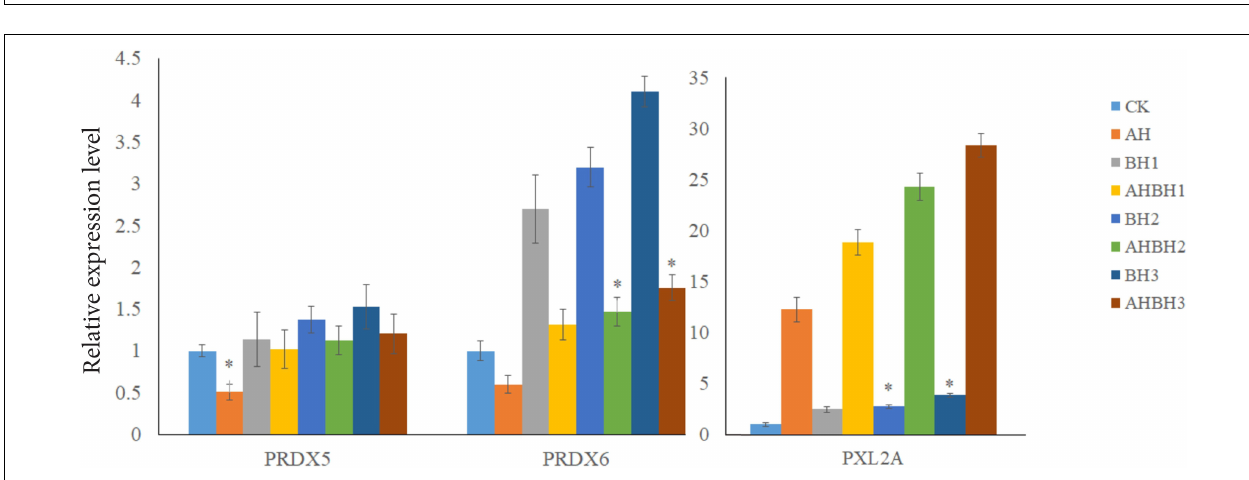
FIGURE 8 | Relative expression of Prx5, Prx6, and PXL2A genes in the hepatopancreas of C. japonica . Infected with A. hydrophila (AH), C. japonica immersed in berberine hydrochloride at 100 mg/L (BH1) and 200 mg/L (BH2), C. japonica immersed in berberine hydrochloride at 300 mg/L (BH3), C. japonica immersed in berberine hydrochloride at 100 mg/L, and injected with A. hydrophila 1 (BHAH1), C. japonica immersed in berberine hydrochloride at 200 mg/L and injected with A. hydrophila of 105 CFU/L (BHAH2), C. japonica immersed in berberine hydrochloride at 300 mg/L and injected with A. hydrophila (BHAH3), and the control group (CK) at 10 5 CFU/L. The bar chart shows significant differences (* P < 0.05).